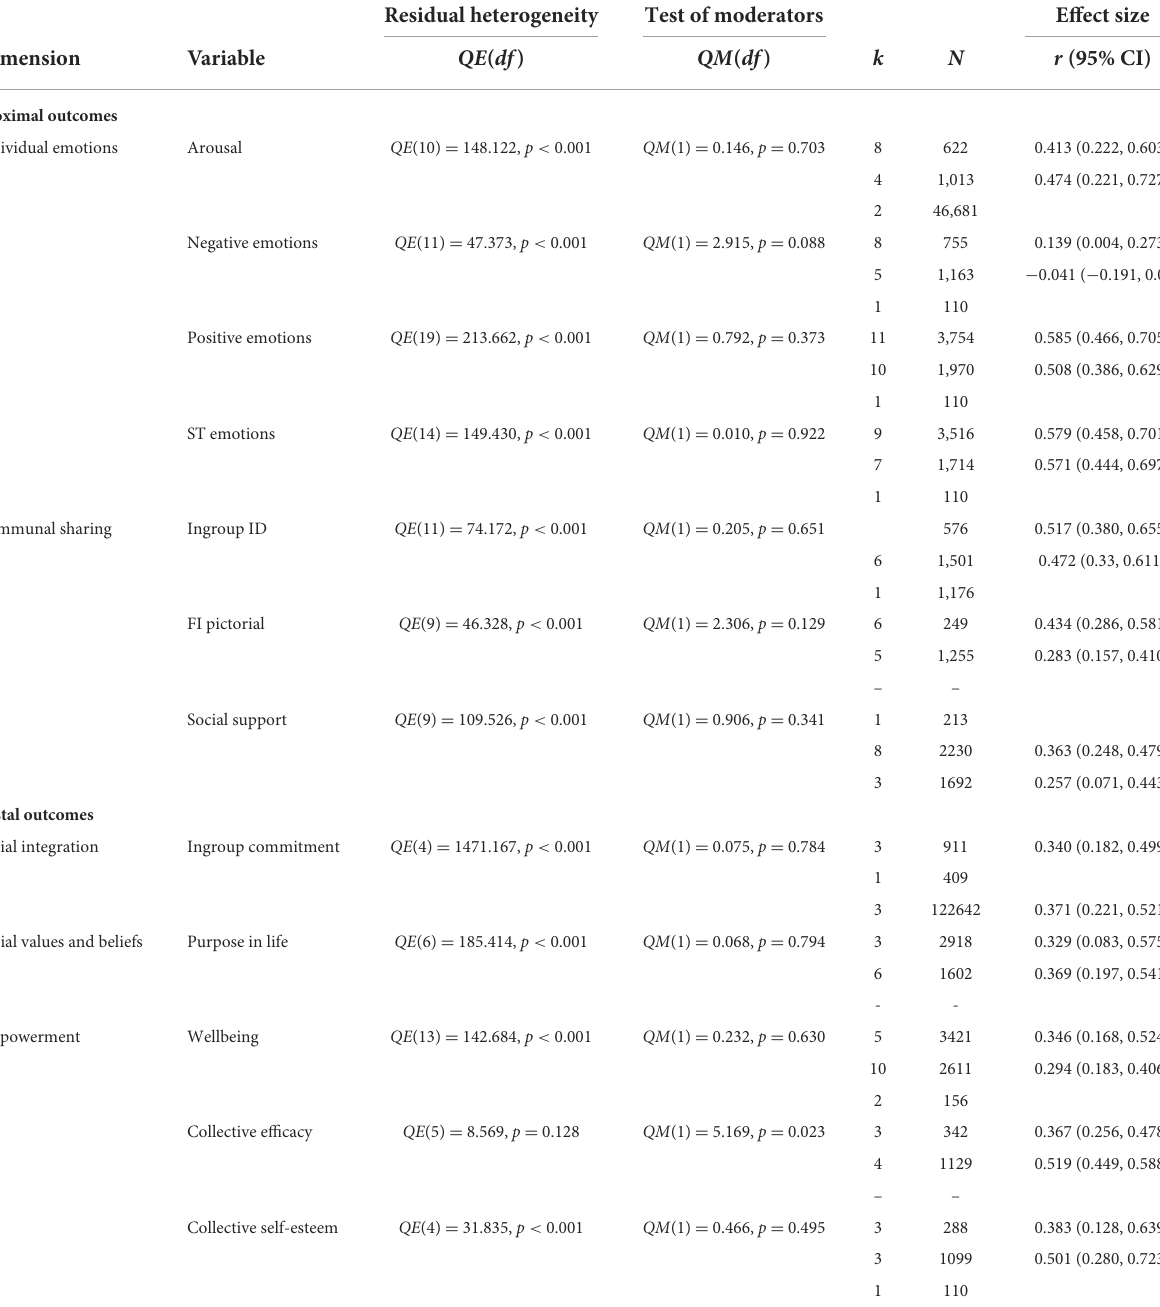
TABLE 4 Pooled correlations between collective effervescence and criterion variables moderated by type of collective gathering. Residual